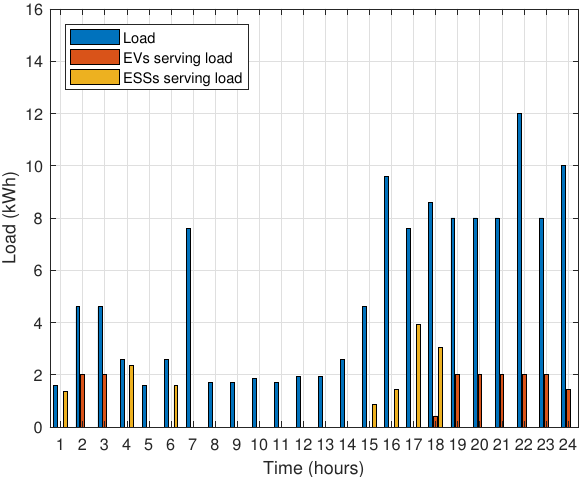
Figure 14. Contribution of EVs and ESSs in serving load. Net energy demand and imported/purchased energy from the utility with and W/O EVs discharging abilities are depicted in Figure 15. It is evident from the results that the developed model significantly reduced the import of energy in peak hours. Furthermore, consumers import minimum energy when utilizing EVs for discharging. On the other side, consumers import more energy when EVs are not fully charged and cannot discharge.